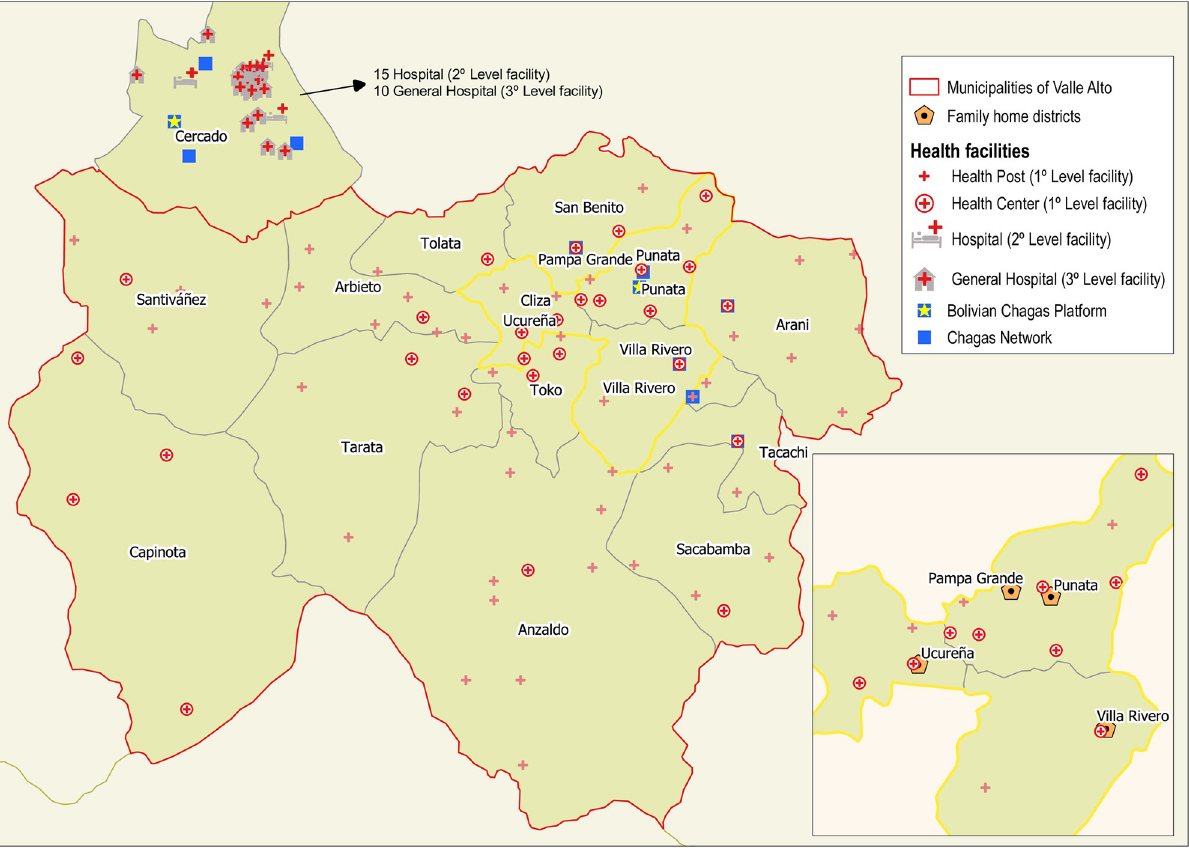
Fig 1. Map of the Valle Alto of Cochabamba and the health facilities in the region. Own creation from cartography of the Ministry of Bolivia 2016. [72]. In addition, it shows the municipality of Cercado where the capital Cochabamba as well as the second- and third-level facilities are located. The Bolivian Chagas Platforms and the Chagas Networks are highlighted. The expanded box shows the districts where families have resided.